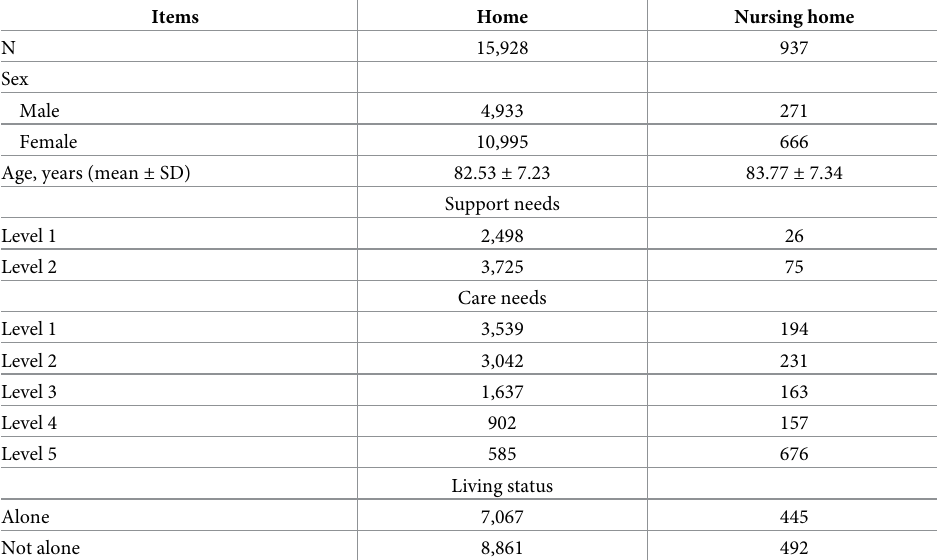
Table 1. Traceable participants’ baseline characteristics in 2016 categorized by group (N = 16,865).